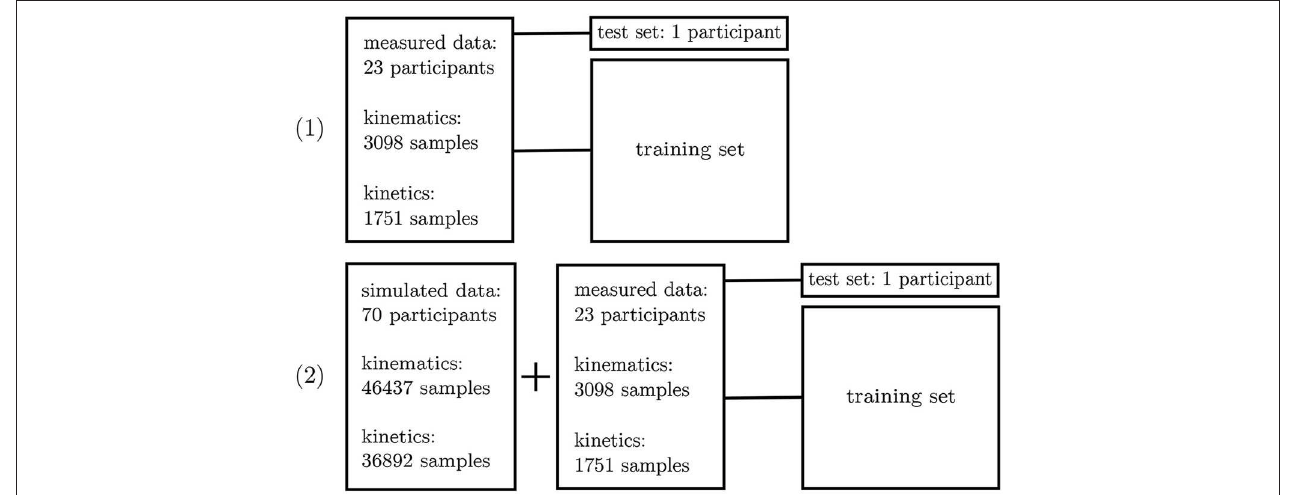
FIGURE 5 | Overview of the leave-one-out validation process. Kinematics and kinetics were treated separately.